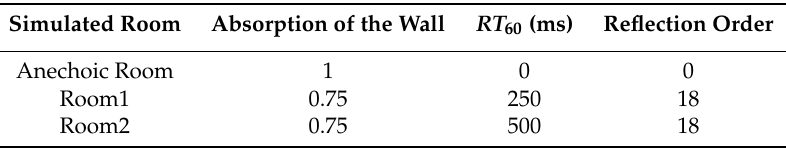
Table 1. Parameters of the testing